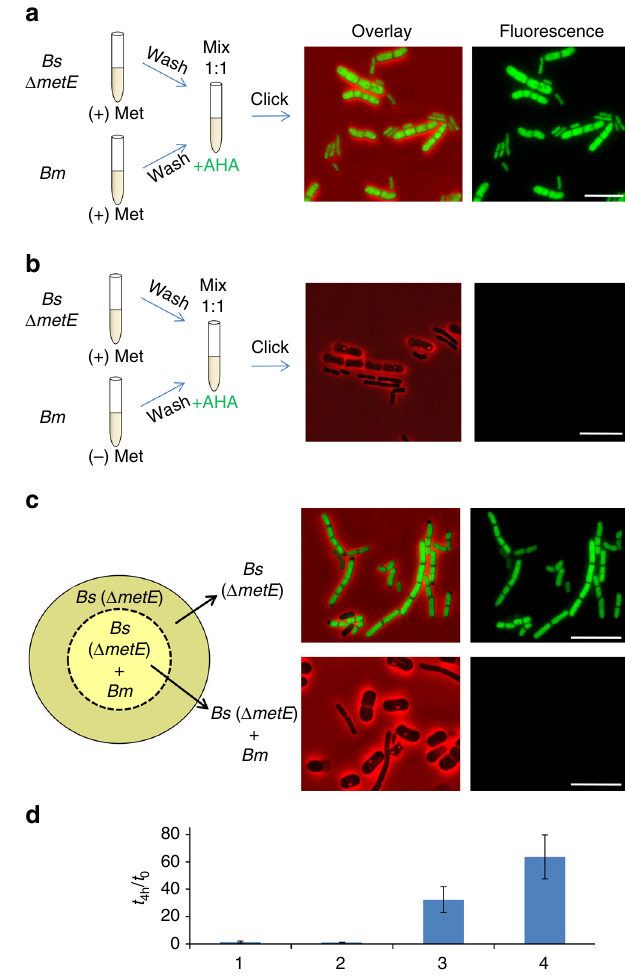
Fig. 5 Bs extracts Met from its neighboring Bm . a , b Bm (OS2) was pre-grown in the presence ( a ) or the absence ( b ) of Met (50 μ g/ml), washed in PBSx1, mixed with Bs (LS5: Δ metE ) and resuspended in S7 supplemented with AHA (1 mM). Cells were incubated for additional 1.5 h, underwent click reaction and visualized by fl uorescence microscopy. Shown are overlay images of fl uorescence from AHA ( green ) and phase contrast ( red ; left panels ), and AHA fl uorescence alone ( right panels ). Fluorescence images were normalized to the same intensity range. c Bm (OS2), pre grown in the absence of Met, and Bs (LS5: Δ metE ) were mixed and incubated in the inner Transwell compartment. For a comparison, Bs (LS5: Δ metE ) was incubated in the outer Transwell compartment. Both the mixture in the inner well, and the Bs grown alone in the outer well, shared the same S7 medium containing AHA (1 mM). After 2 h of incubation, the cells underwent click reaction and visualized by fl uorescence microscopy. Shown are overlay images of fl uorescence from AHA ( green ) and phase contrast ( red ; left panels ), and AHA fl uorescence alone ( right panels ). Fluorescence images were normalized to the same intensity range. d Shown are CFU ratios at t 4-h / t 0 of the following cultures: (1) Bs (LS5: Δ metE ) grown in the absence of Met. (2) Bs (OS21: Δ metE , Δ ymdB ) co-cultured with Bm (OS2) in the absence of Met. (3) Bs (LS5: Δ metE ) co-cultured with Bm (OS2) in the absence of Met. (4) Bs (LS5: Δ metE ) grown in the presence of Met. Bm OS2 cells were pre-grown in the absence of Met. Shown are average values and s.d. of three independent experiments. Scale bars represent 10 µ